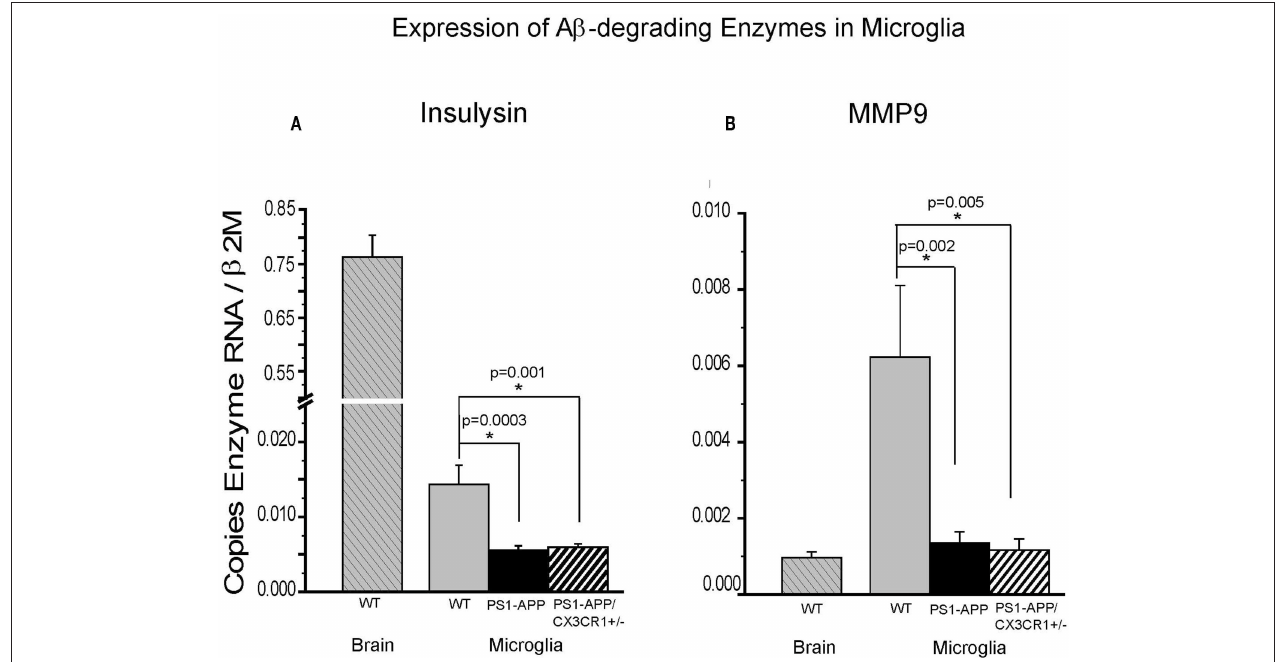
FIGURE 6 | Effects of CX3CR1 deficiency on expression of IDE and MMP9 in microglia from WT, PS1-APP, and PS1-APP-CX3CR1 + / − mice. Expression of IDE (A) MMP9 (B) was analyzed by qPCR on RNA isolated from microglia freshly harvested from brains of PS1-APP, WT littermates, and PS1-APP-CX3CR1 + / − mice at 24 months of age: WT brain ( n = 6), WT microglia ( n = 6), PS1-APP ( n = 10), and PS1-APP-CX3CR1 + / − ( n = 6). Levels of enzymes are expressed relative to the β 2M housekeeping gene and bars represent mean ± SEM. * represent statistically